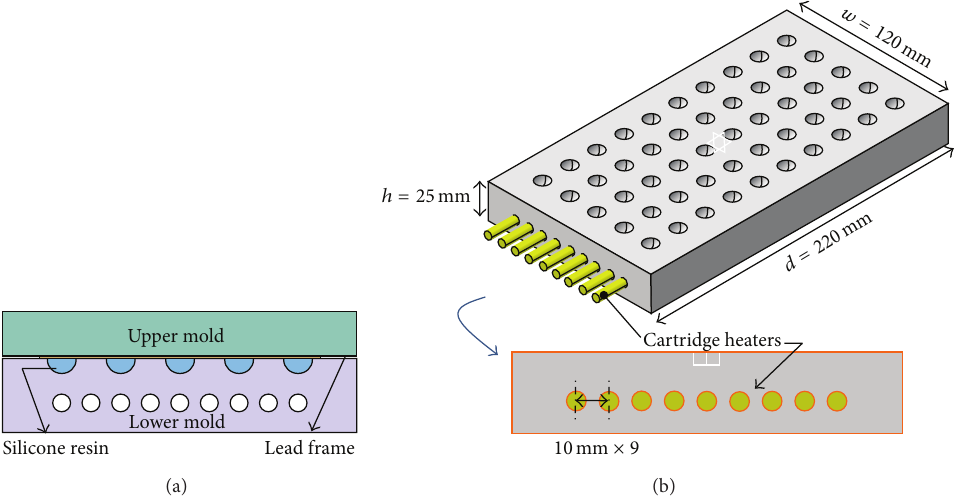
Figure 6: Analysis model for LED lens molding. (a) Layout of large area LED lens molding. (b) Lower mold specification for LED lens